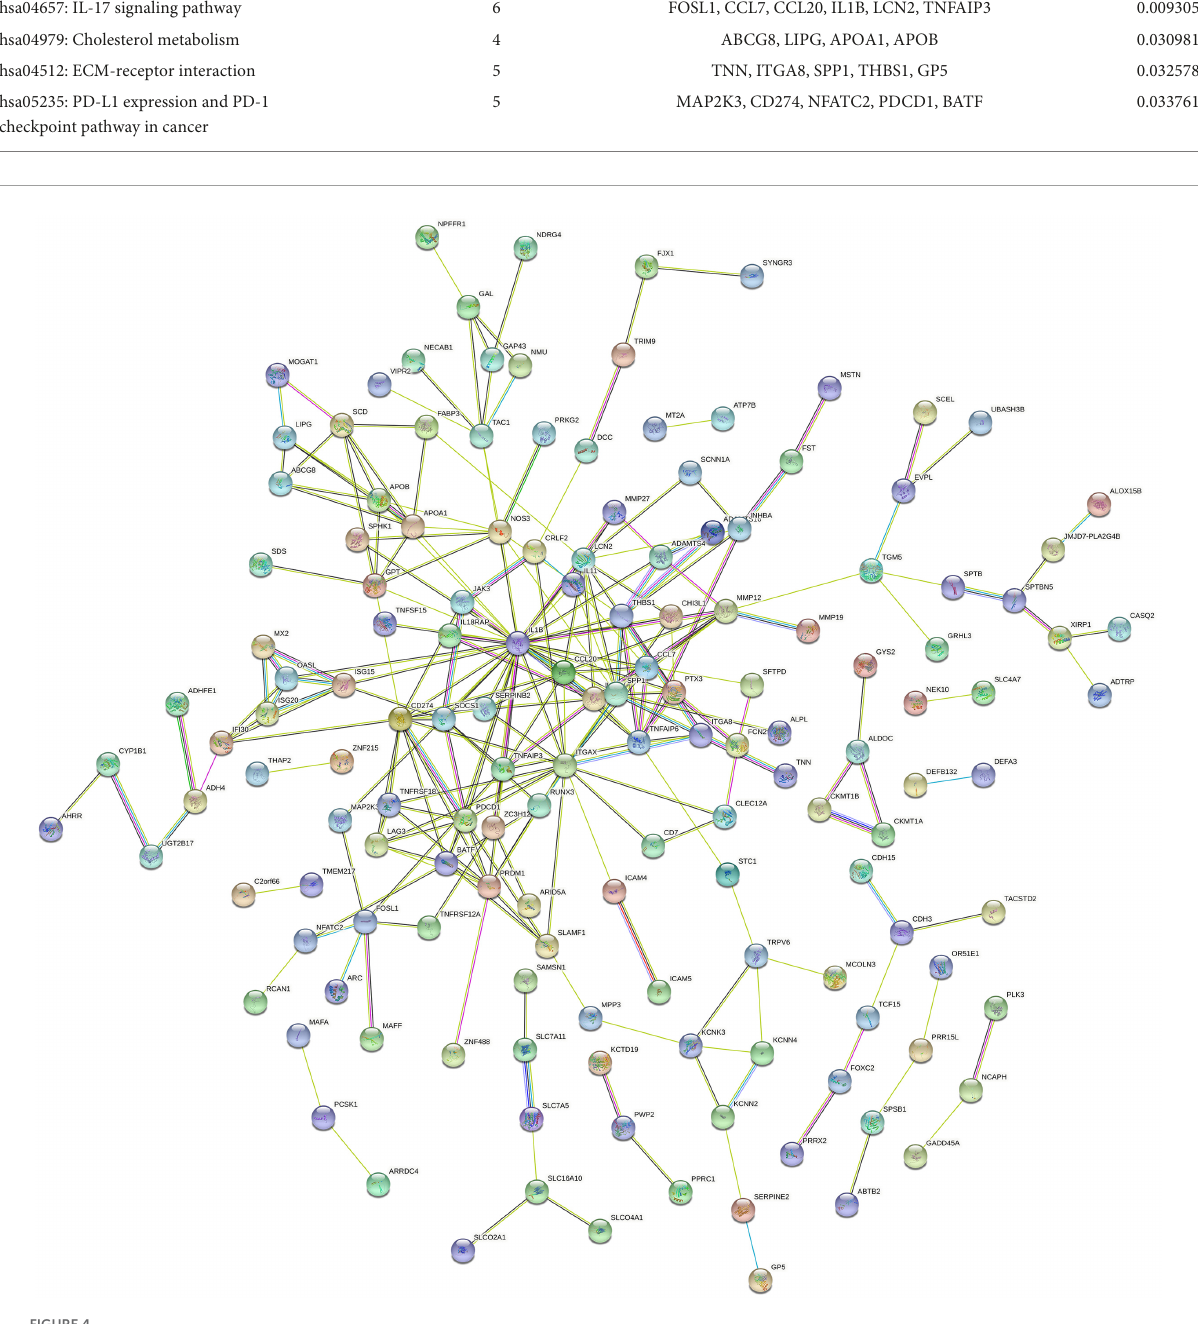
FIGURE4 Protein–protein interaction network of proteins constructed by the DEGs. The network included 149 nodes and 254 edges. Medium confidence = 0.40; PPI, protein–protein